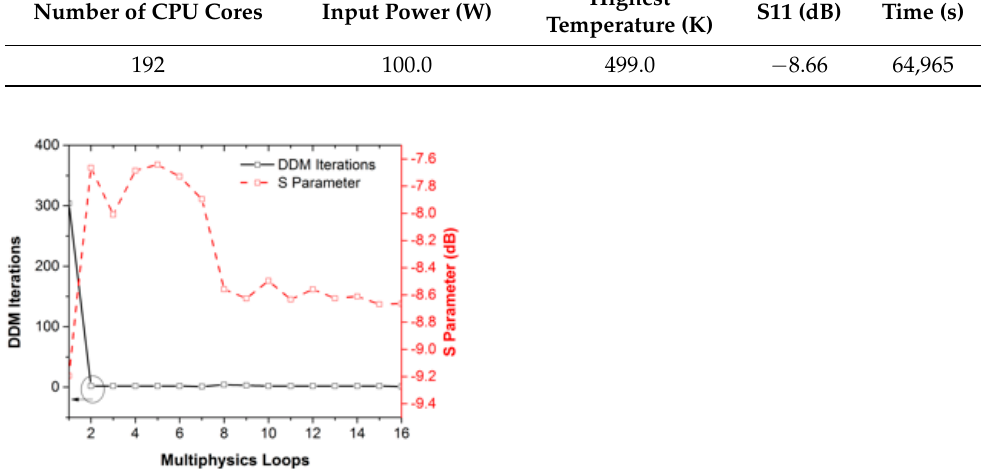
Figure 10. DDM iteration step change and S parameter change during the multiphysics simula- tion.